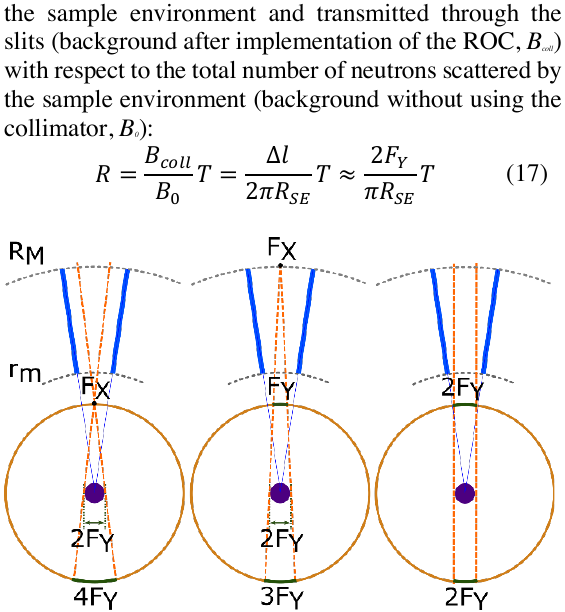
Fig. 4. Representation of the amount of sample environment region (orange circle) “observed” by the slit (green arcs) for three extreme cases of blade configuration corresponding to focal lenghts F lying either before r (left), between R and r X m M m (center), or beyond R (right). For each case the arcs observed M by the slit can be effectively approximated to ~4 F Y